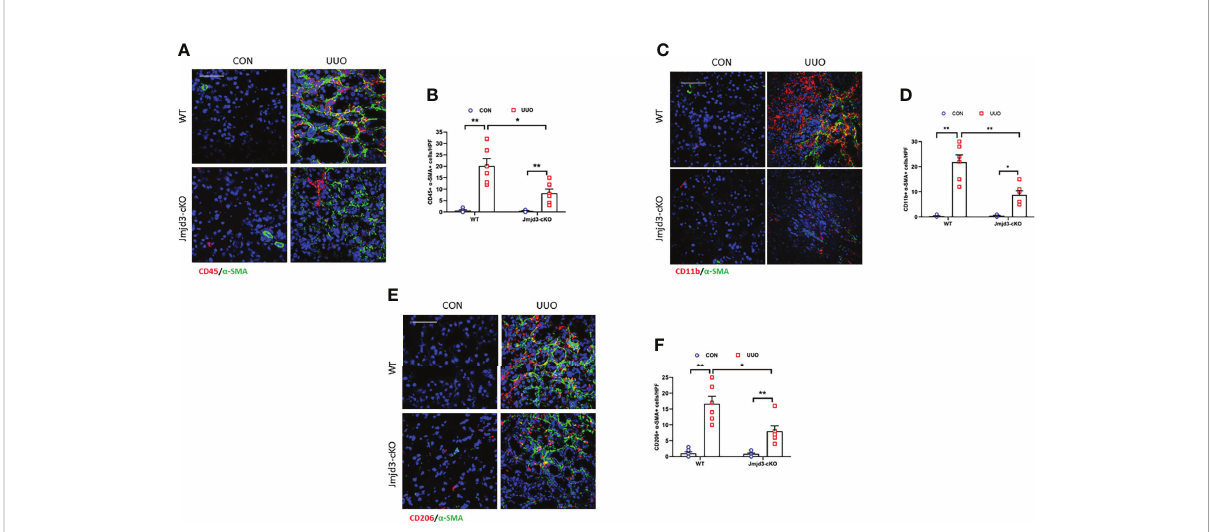
FIGURE 4 Myeloid Jmjd3 deletion attenuates myeloid fi broblast activation and M2MMT in kidneys with obstructive injury. (A) Kidney sections were stained for CD45 (red) and a -SMA (green). (B) Quantitative analysis of CD45 + - a -SMA + cells in the kidneys. (C) Kidney sections were stained for CD11b (red) and a -SMA (green). (D) Quantitative analysis of CD11b + - a -SMA + cells in the kidneys. (E) Kidney sections were stained for CD206 (red) and a -SMA (green). (F) Quantitative analysis of CD206 + - a -SMA + cells in the kidneys. * P <0.05 or ** P <0.01; n = 6; Bar = 50 m m. M2MMT=M2 macrophage to myo fi broblast transition; WT, wild-type; cKO, conditional knockout; HPF, high-power fi